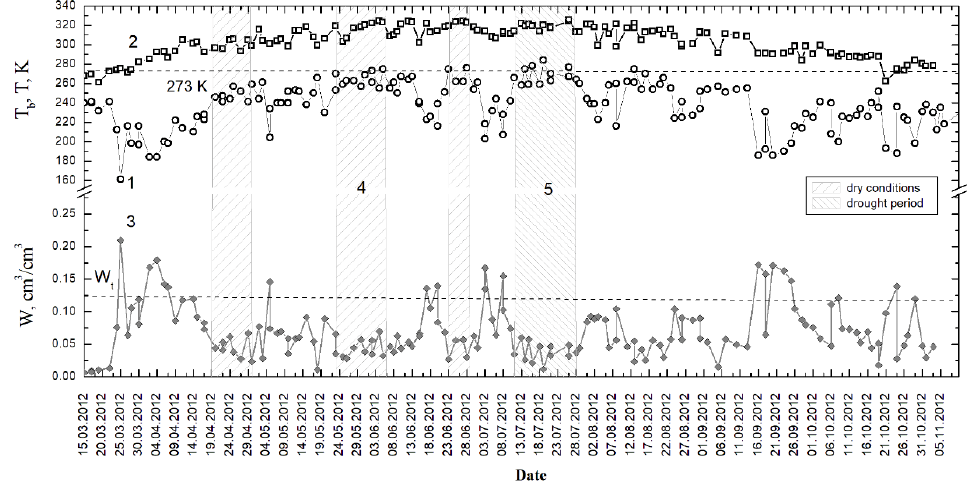
Figure 8. Seasonal dynamics of T BH , T and W, 1—brightness temperature T BH , 2—temperature T, 3— volume fraction of water in soil W: 4—periods of drought, 5—period of drought which ended with the declaration of a state of emergency.